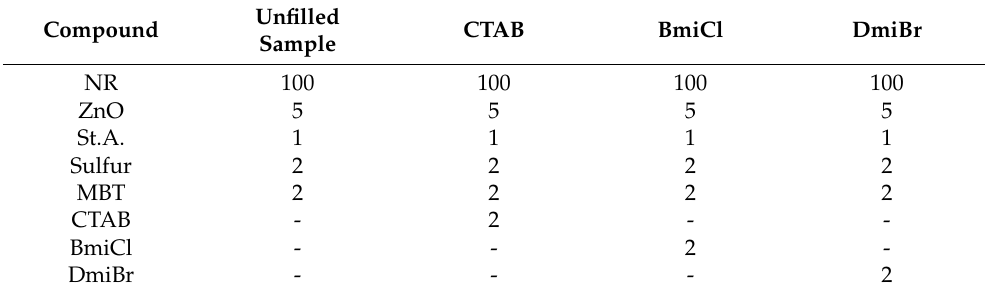
Table 1. General recipes of the unfilled NR compounds used in this study; phr, parts per hundred of rubber. Compound